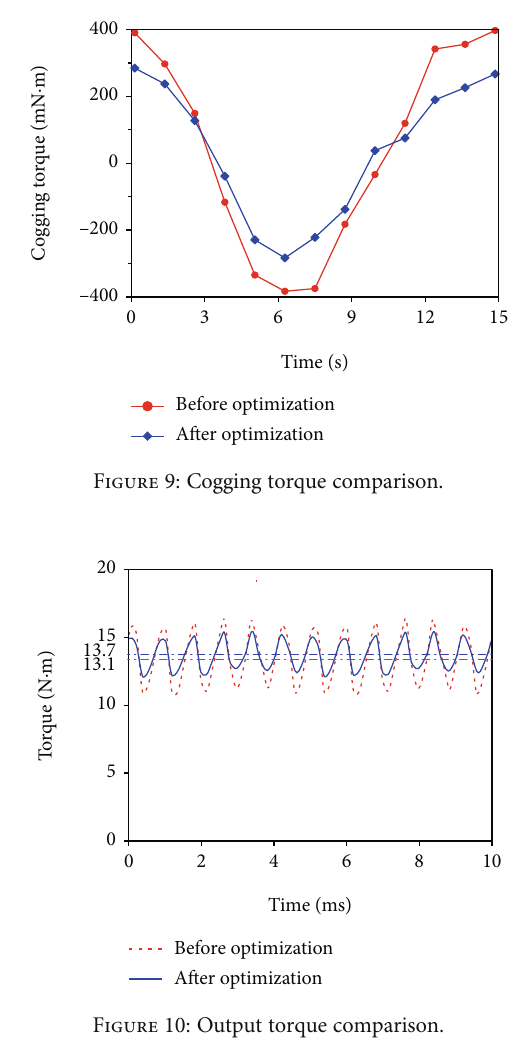
Figure 10: Output torque comparison.